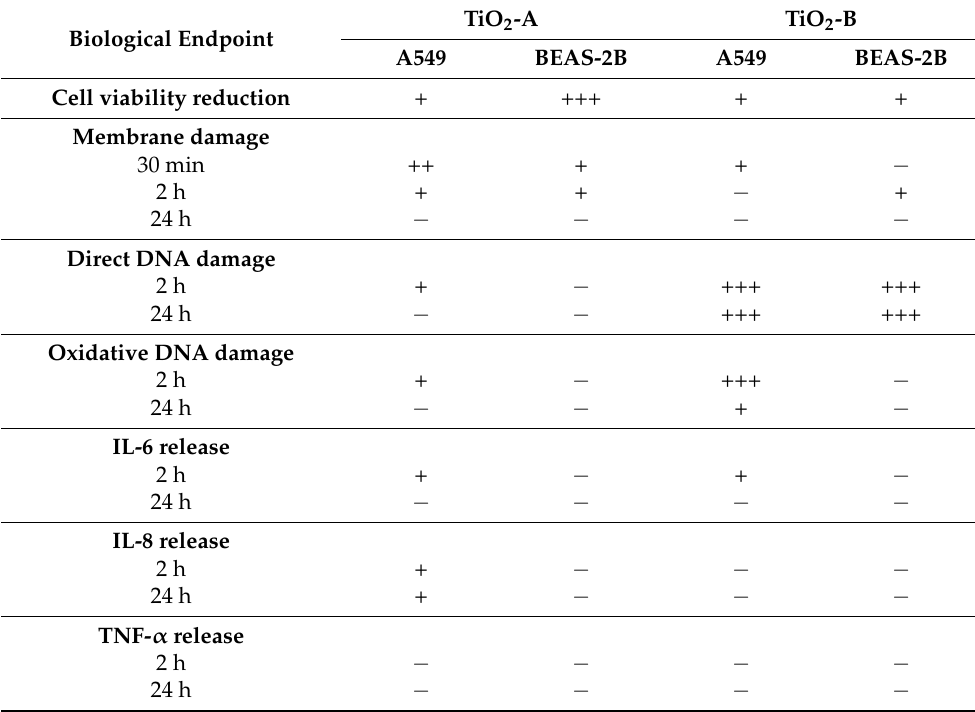
Table 2. Cellular response induced by exposure to TiO 2 -A and TiO 2